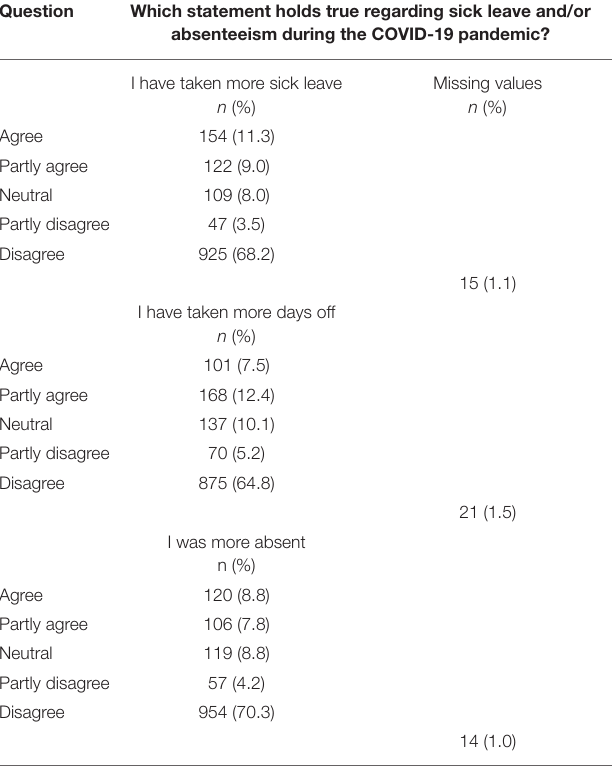
TABLE 2 | Work-related questions regarding absenteeism and sick leave.